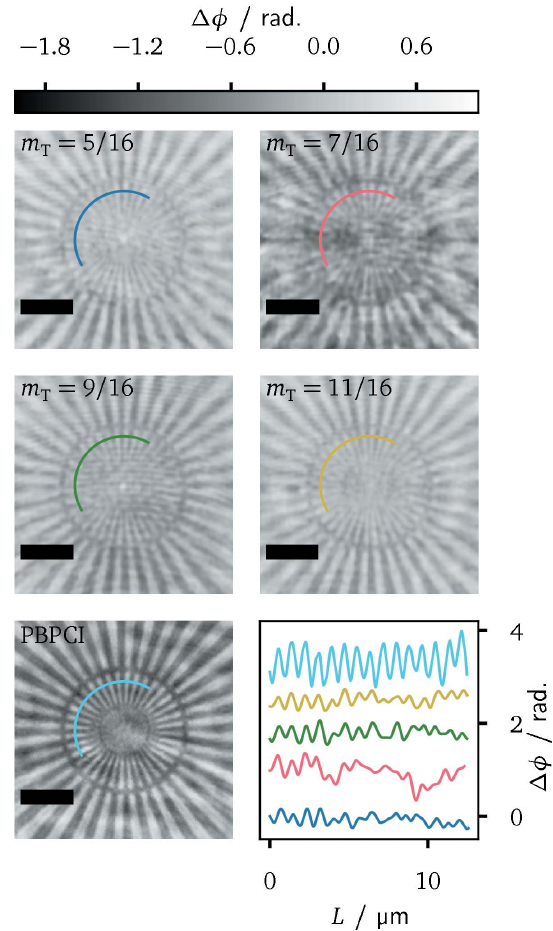
Figure 9 Phase reconstructions of a Siemens star for different Talbot orders and for PBPCI. The scale bar indicates 5 m m length in all reconstructions. The two visible indicators within the Siemens star mark spoke line widths of 500 nm and 200 nm, respectively. The panel on the bottom right shows section profiles along the indicated circular line segments. The length L of the line segments, that the phase shift values are plotted over, is measured anti-clockwise. In support of a clearer depiction, the section profiles are offset with respect to each